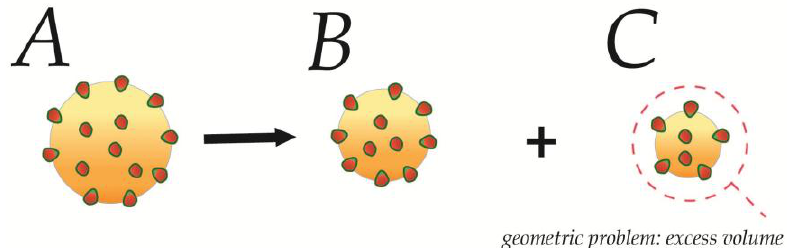
Figure 9. Fission of closed compartments. A closed spherical membrane compartment undergoes fission and generates two smaller compartments. As the integrated elastic energies of A – C are assumed to be identical, more favorable insertion per surface area are assumed to be permitted on the fission products. However, there will be an excess of volume, which will be expected to destabilize one or both of the fission products (see red dashed circle), which will react by changing morphology if energetically favorable.